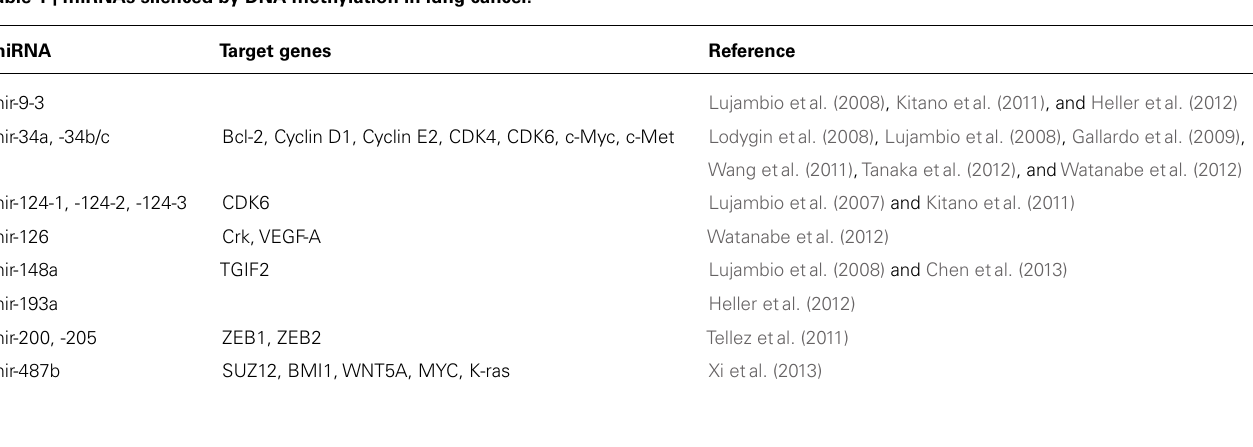
Table 1 | miRNAs silenced by DNA methylation in lung